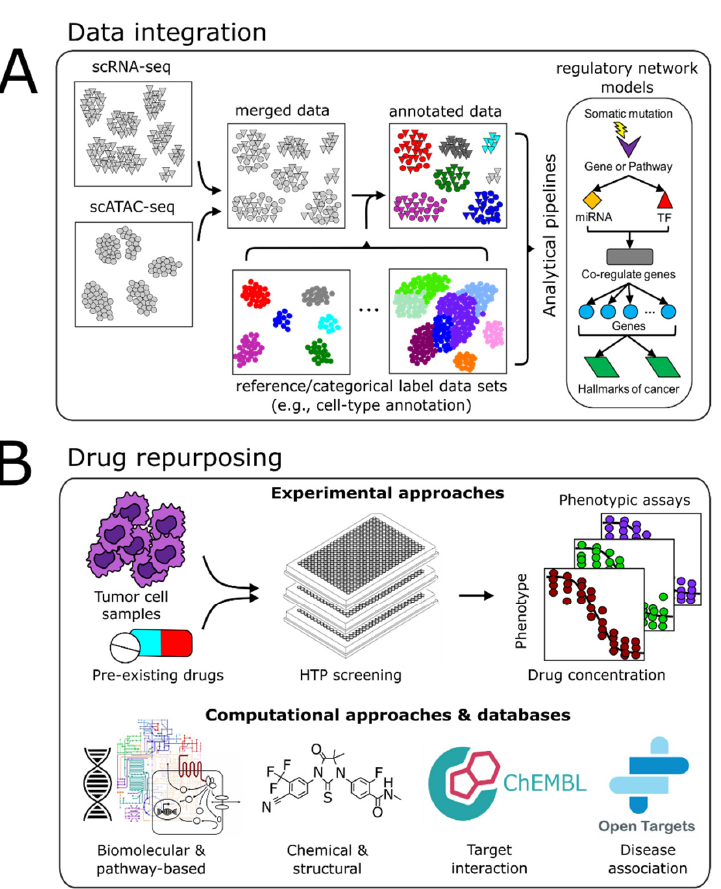
Figure 2. Data integration and drug repurposing. ( A ) Multiple computational approaches have